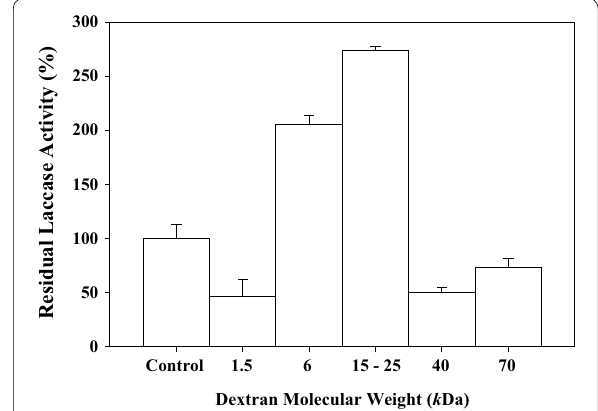
Fig. 1 Effect of dextran molecular weight on the residual laccase activity after lyophilization, using syringaldazine as substrate. The residual laccase activity was defined as the specific activity of lyophilized enzyme to that of the lyophilized enzyme trial that is lacking the additive